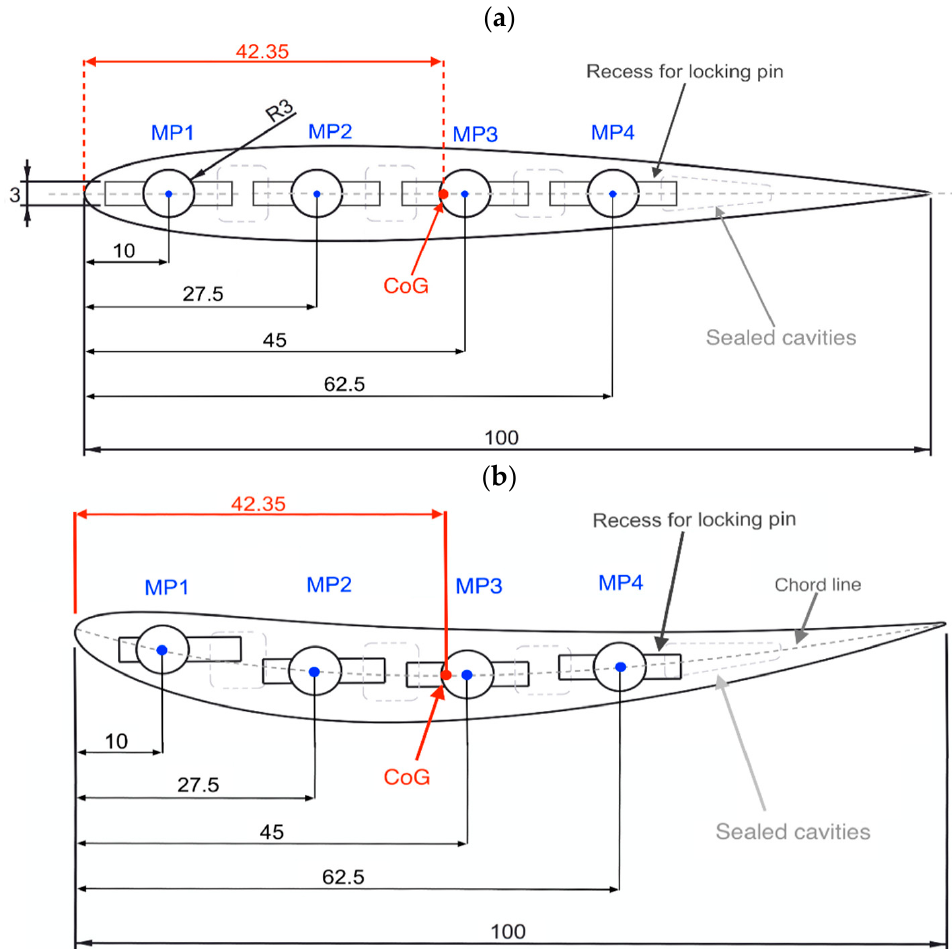
Figure 3. Pivot point location, dimensions in mm, and the centre of gravity location (CoG) for ( a ) NACA 0012 and ( b ) NACA 6412.